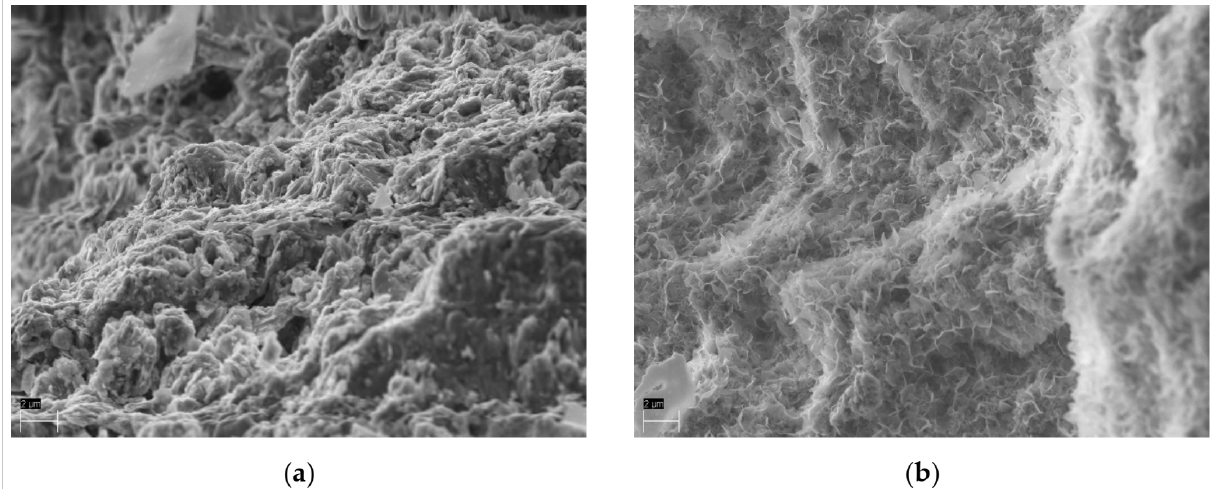
Figure 6. FEG-SEM pictures of: ( a ) unloaded natural zeolite and ( b ) N & P loaded zeolite with precipitated